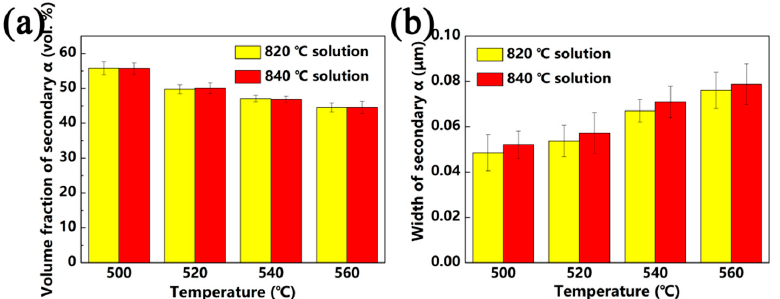
Figure 8. Microstructure features of the α phase that was solution-treated at the β region for 1 h and aged for 8 h: ( a ) volume fraction of secondary α ; ( b ) width of secondary α .